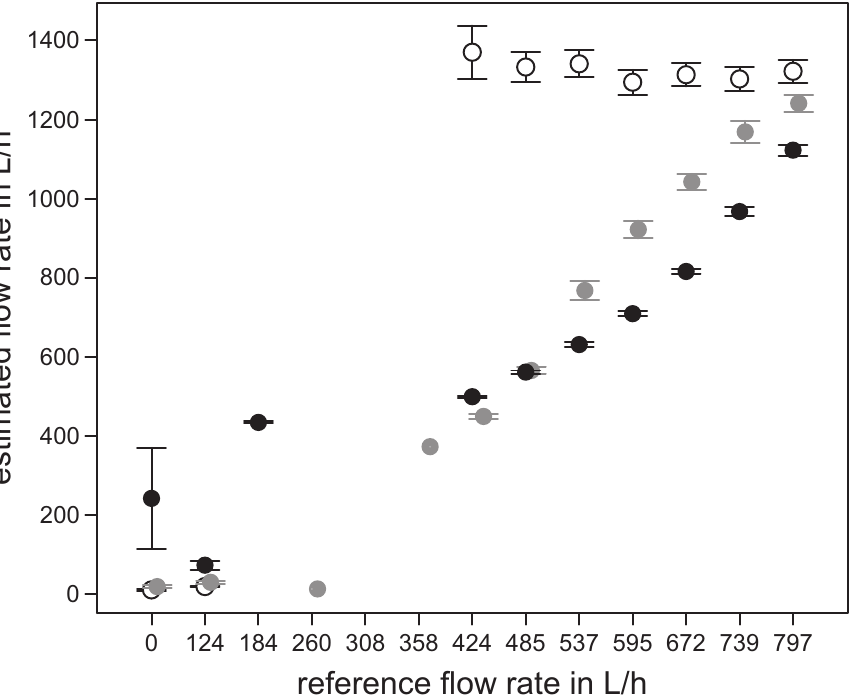
Figure 6. Flow rate estimation from temporal delayed waveforms in the proof of principle study. The plot shows the mean values and standard errors for reference flow rates that ranged from 0 to 797 L/h. Sensors were spaced 5 mm apart (open circles, adjacent sensors), 10 mm apart (gray circles) and 15 mm apart (black circles). Data points of estimated flow rates exceeding the range of 0 to 2000 L/h were excluded from this figure (about 35% for adjacent sensors, 25% for 10 mm and 3% for 15 mm sensor distance). Please note that reference values along the x -axis are not equally